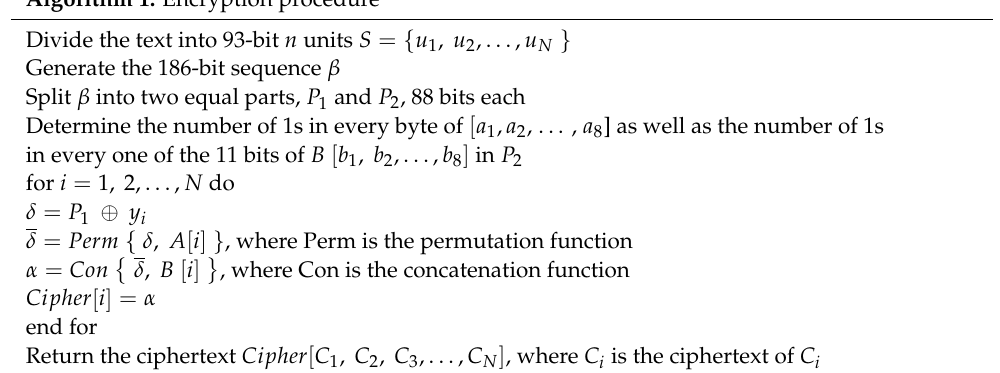
Algorithm 1: Encryption